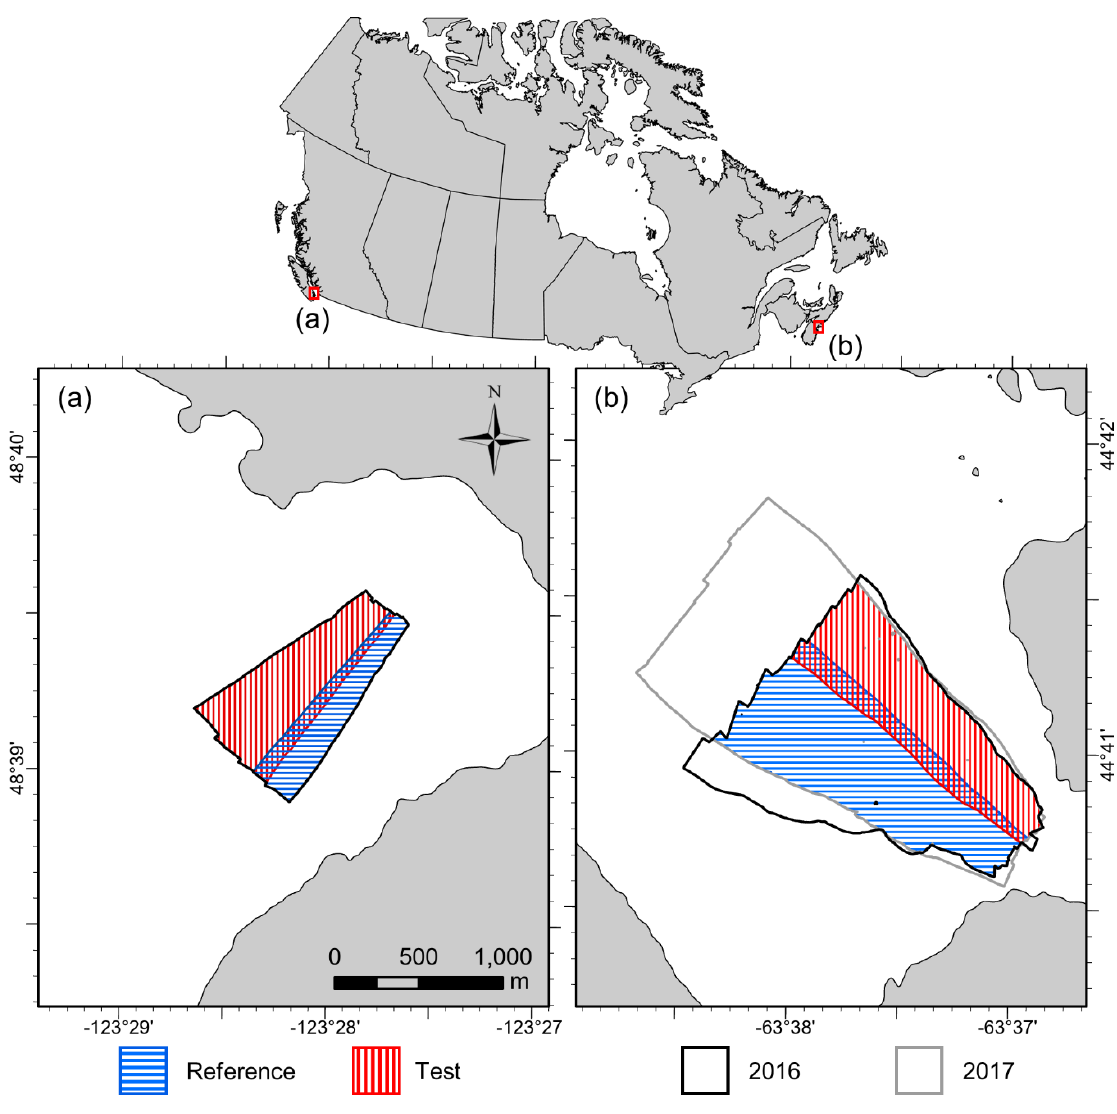
Figure 1. Locations of ( a ) Patricia Bay, British Columbia, and ( b ) Bedford Basin, Nova Scotia, Canada. Blue and red hatches delimit reference and test areas used for bulk shift simulations at Patricia Bay in 2016, and Bedford Basin in 2016 and 2017. Test areas contain the “shift” datasets, which are compared to the withheld portion of the “target”.